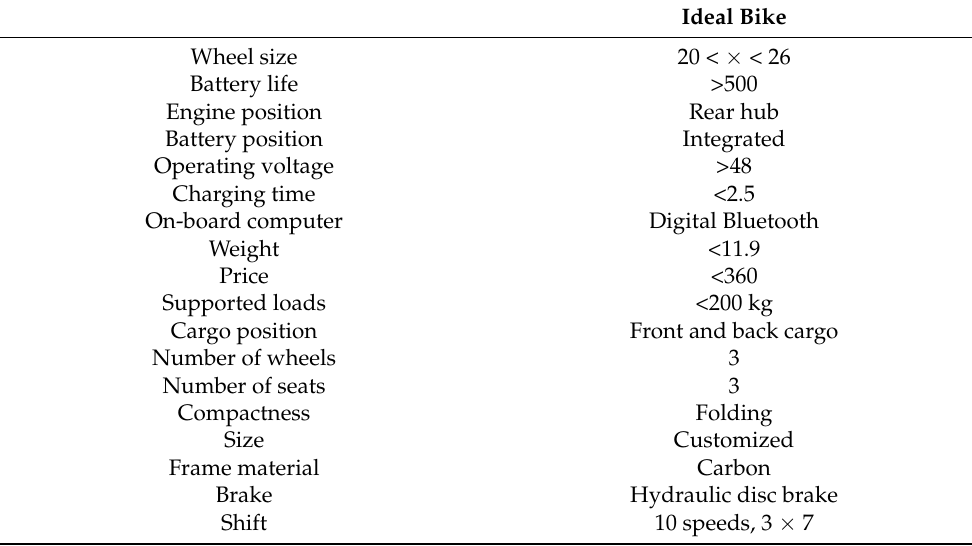
Table 5. Specifications of an ideal